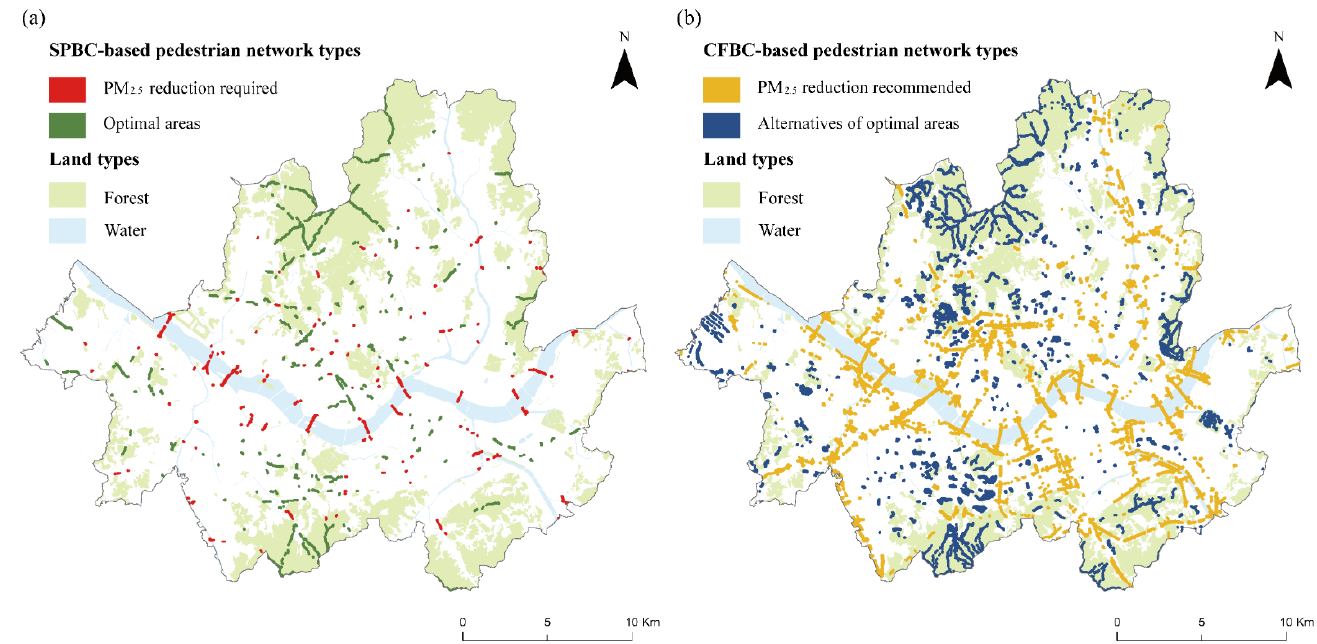
Figure 4. The comparison of mean ( a ) SPBC and ( b ) CFBC values according to roadway types and PM 2.5 dispersion models.